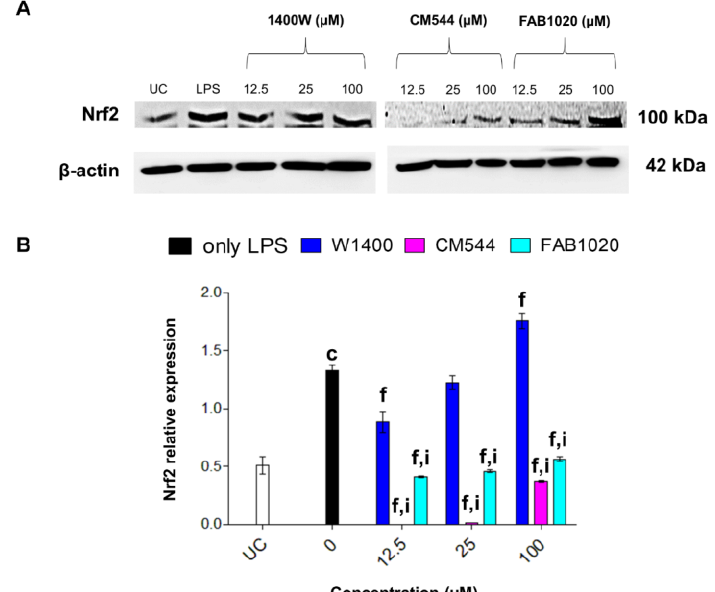
Figure 7. Nrf2 protein expression in LPS ‐ stimulated human monocytes in the presence of increasing concentrations of 1400W, CM544 and FAB1020 after 24 h. ( A ) Protein bands from a representative experiment. β‐ actin is used as loading control. ( B ) Bar graphs display densitometric values expressed as mean densitometric optical intensities (D.O.I) normalized on those of the loading control. UC = untreated cells. c = p < 0.0001 between LPS ‐ stimulated cells and untreated cells. d = p < 0.01, e = p < 0.001 and f = p < 0.0001 between LPS ‐ stimulated cells and LPS ‐ stimulated cells treated with compounds; g = p < 0.01, h = p < 0.001 and i = p < 0.0001 between LPS ‐ stimulated cells treated with 1400W and LPS ‐ stimulated cells treated with CM544 and FAB1020 at the same concentration.